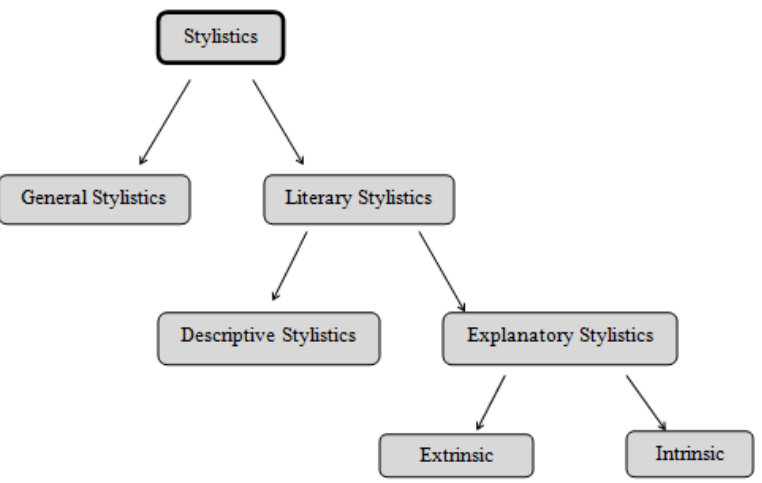
Figure 1 – Types of Stylistics (the figure is set by the